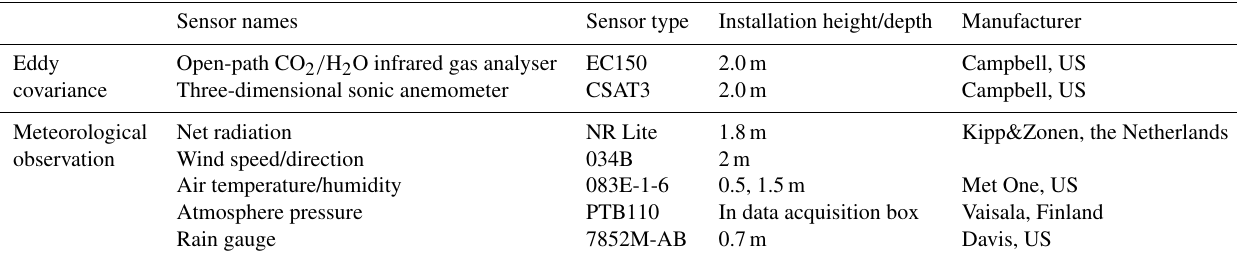
Figure 1. (a) Location of the study site in the Qinghai Lake basin in the northeastern part of the QTP. (b) Eddy covariance system measuring water and CO 2 fluxes between the land surface and the atmosphere in the alpine swamp meadow. Table 1. Information about the sensors installed in the alpine swamp